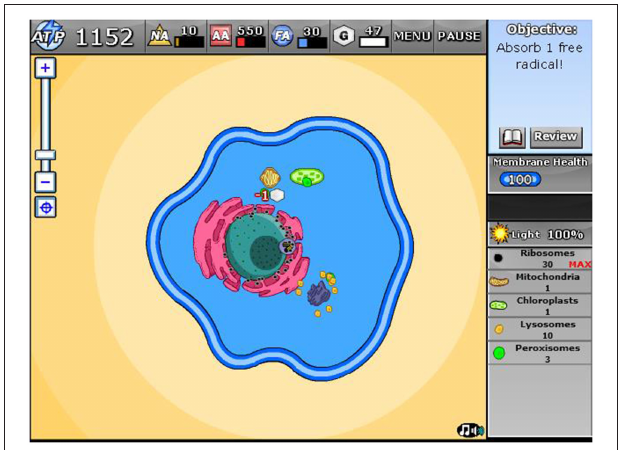
FIGURE 2 | The screenshot shows a scene from Level 5 with the presentation of the current objective in the upper right-hand area and the available resources in the lower right-hand area (with permission of Carolina Biological Supply